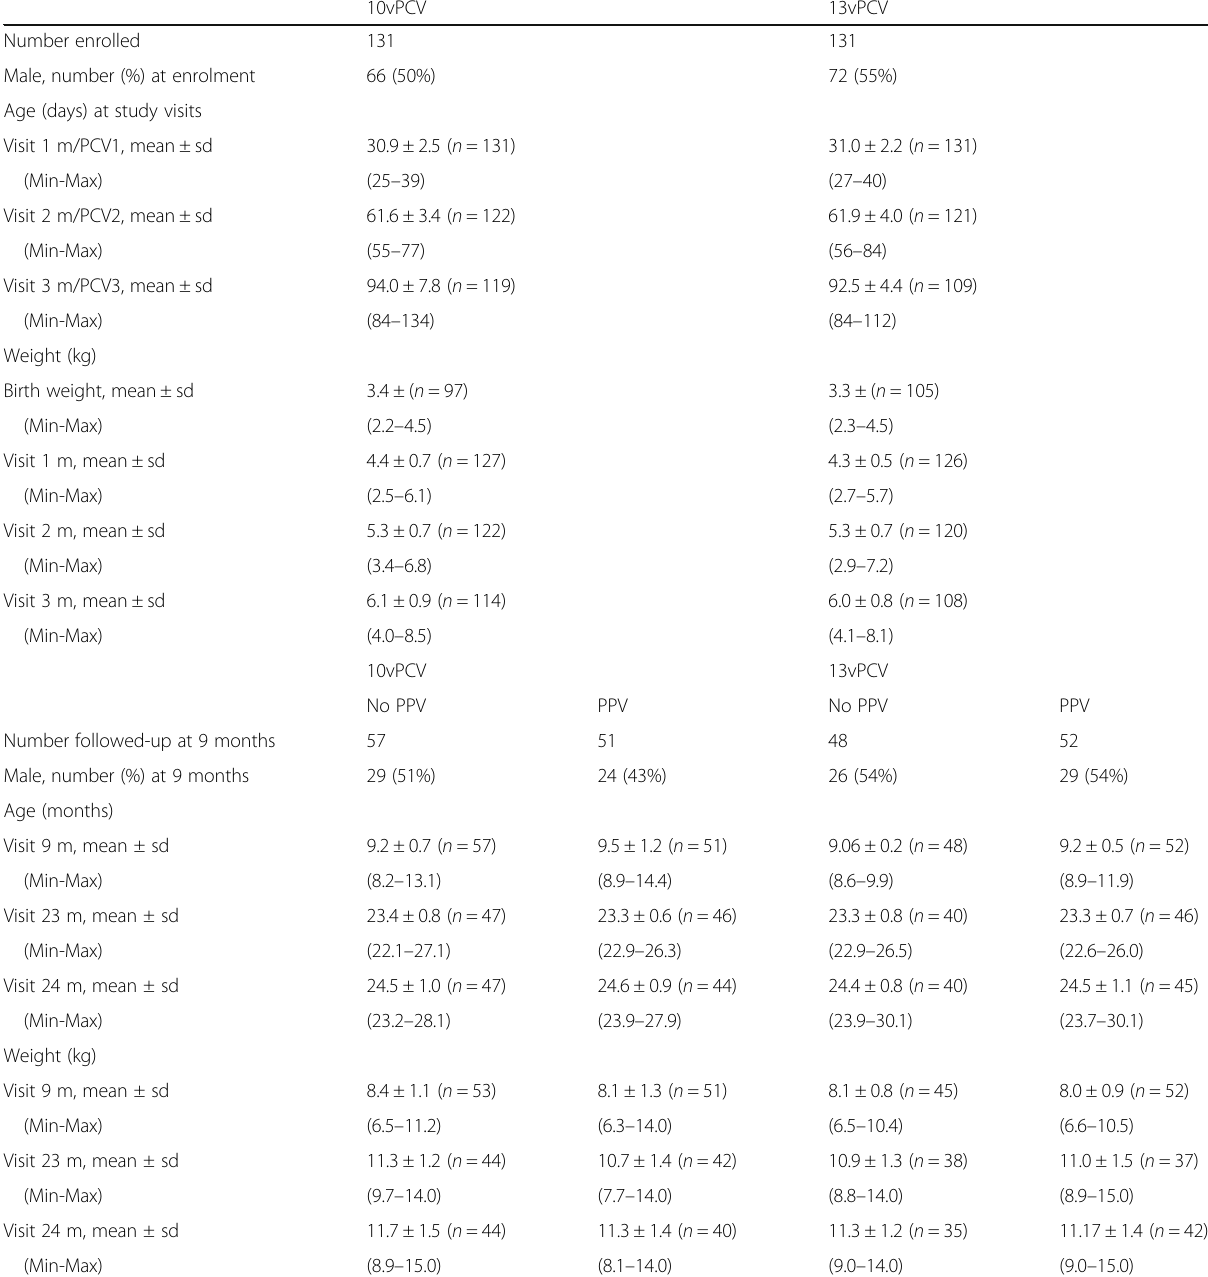
Table 2 Description of study population according to randomization groups 10vPCV 13vPCV 131